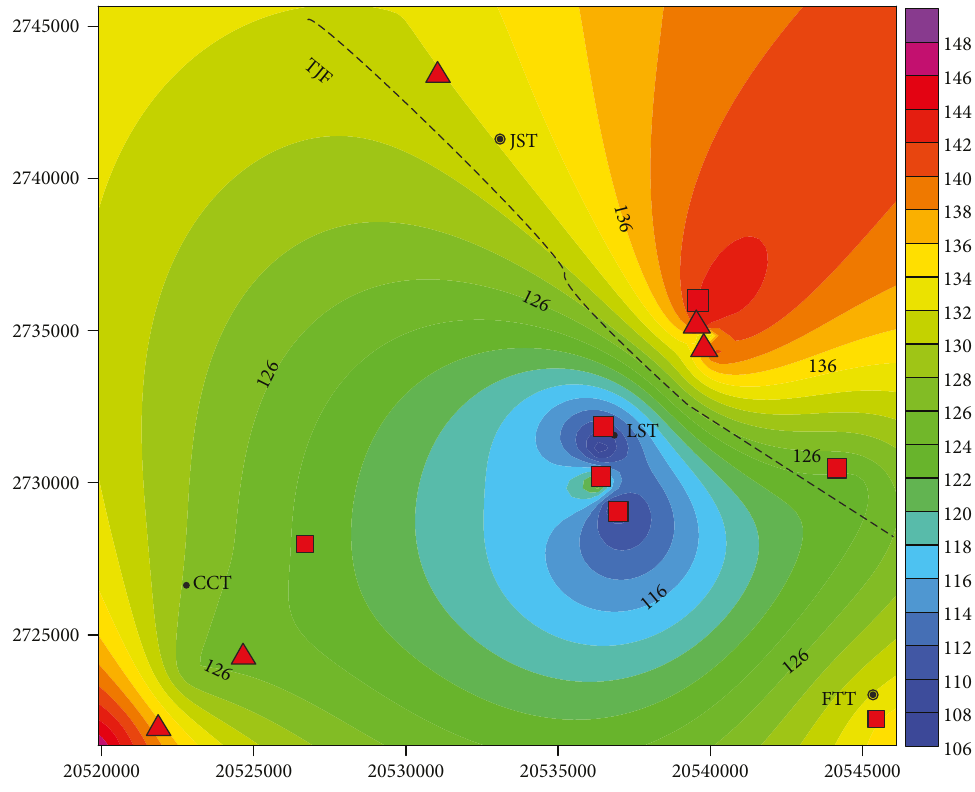
Figure 7: Contour map reservoir temperatures determined in “ selected reservoir temperatures ” of the study area (red square and triangle refer to thermal well water and thermal spring water. For abbreviations, see Figure